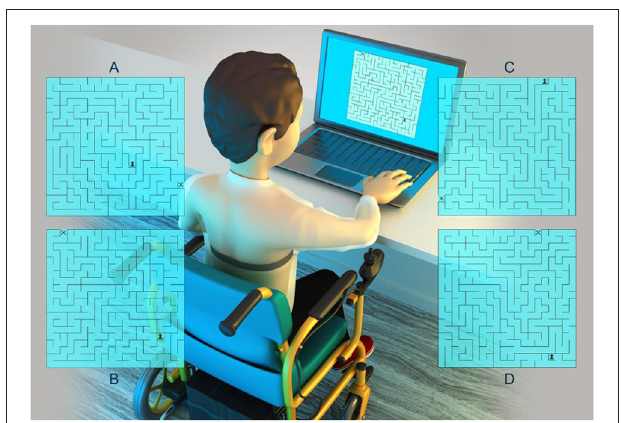
FIGURE 1 | Visualization of experimental set up. Mazes (A–D) represent the four mazes used in this study. The range was of one to four mazes performed for the participants during 5